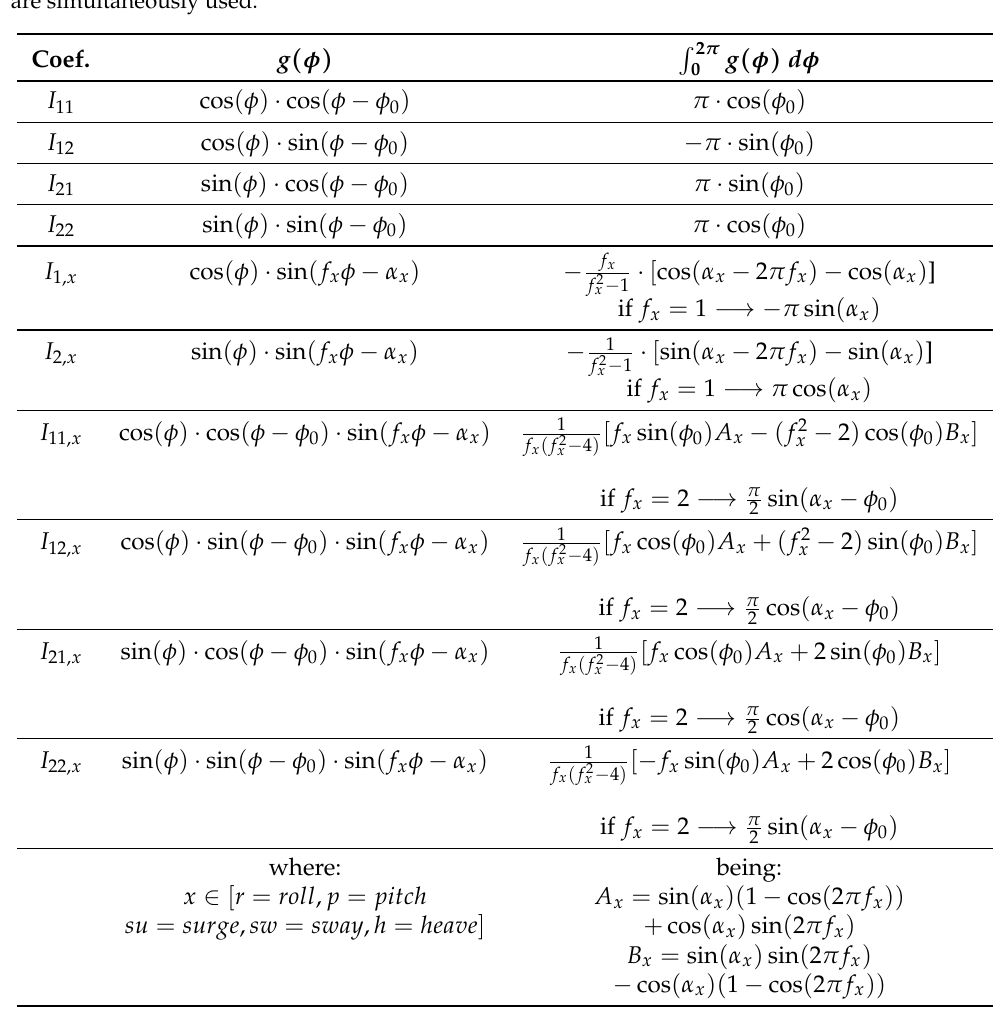
Table A1. Auxiliary integrals for computation of the rotational- and translational-motion Fourier coef- ficients given by Equations (A3)–(A6), respectively. Note that not all possible subscript combinations are simultaneously